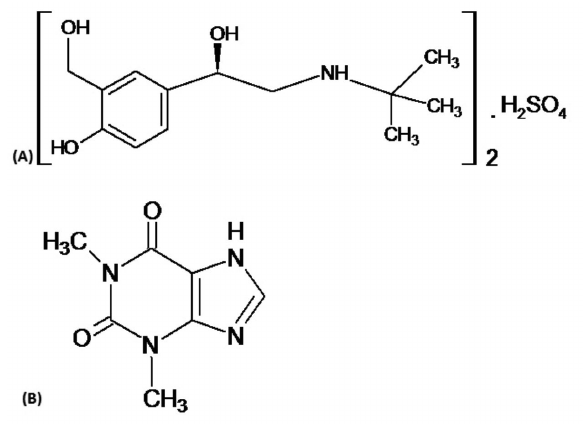
FIGURE 1 - Chemical Structure of (A) levosalbutamol sulfate and (B)